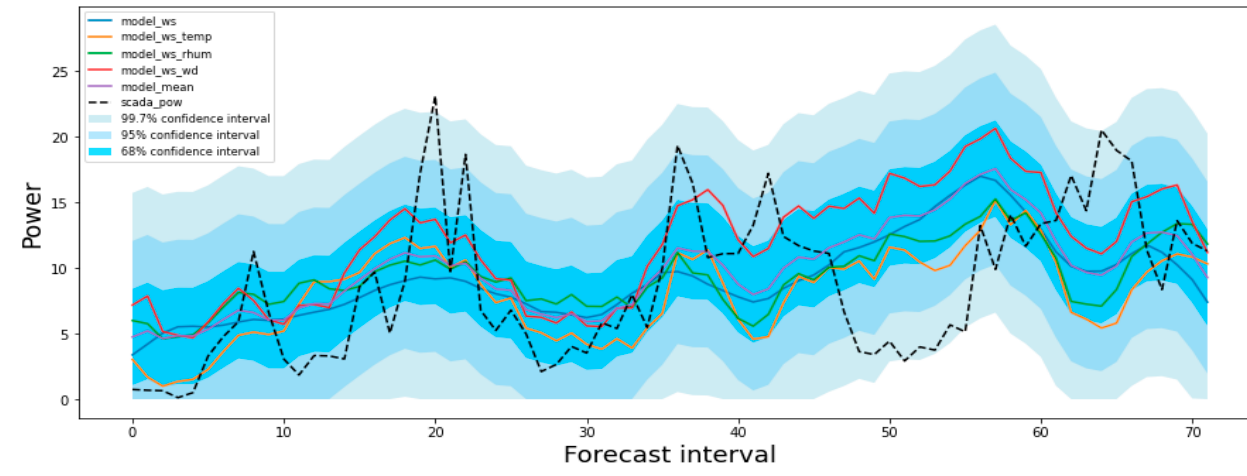
Figure 16. Confidence intervals and deterministic predictions comparison with actual values.